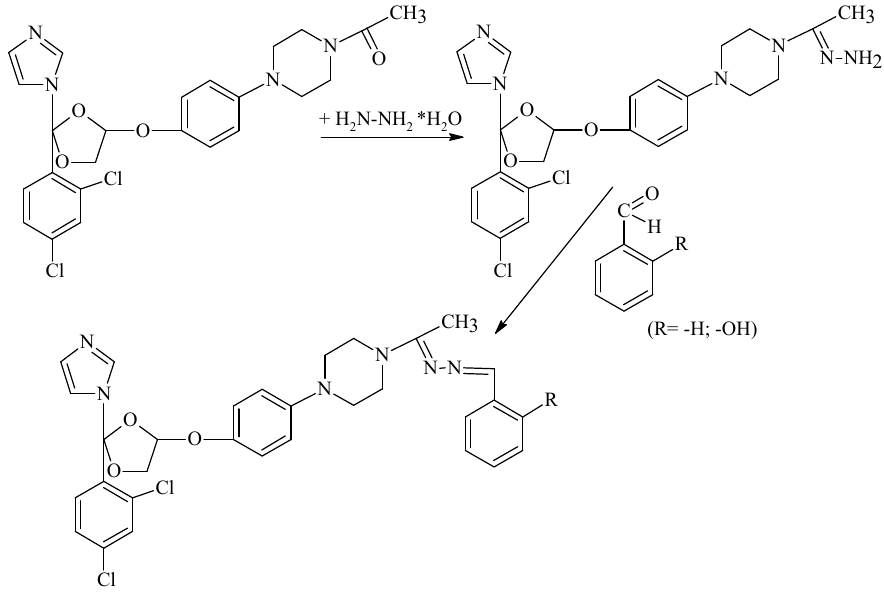
Figure 3. Scheme of obtaining ketoconazole derivatives. The synthesized compounds are in the form of white to pink crystalline powders,